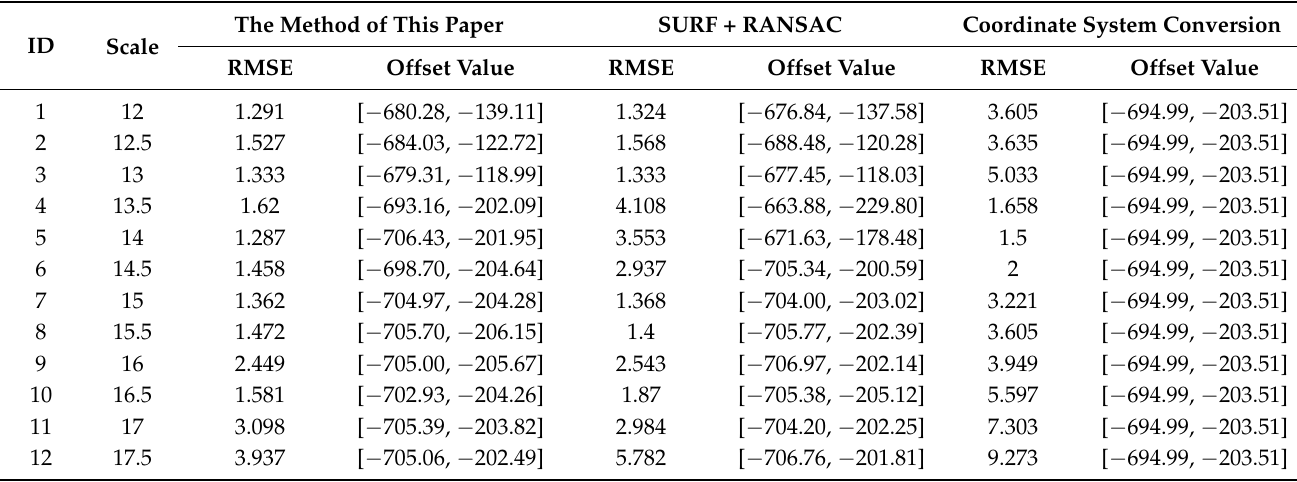
Table 1. Registration results of three methods in remote sensing maps of Beijing.